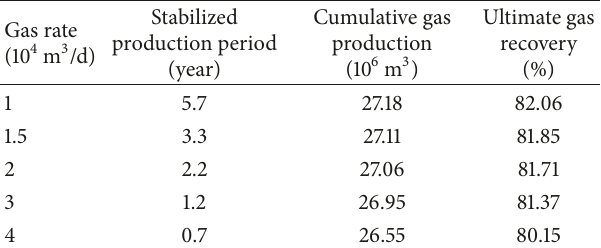
Table 2: Stabilized production period and gas recovery under different gas rates.